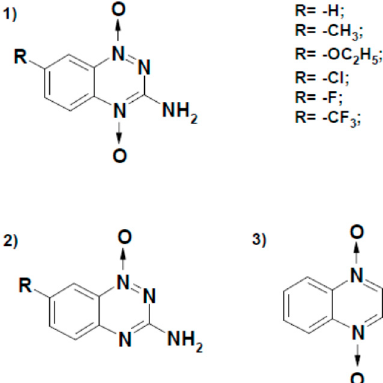
Figure 8. Structural formulae of aromatic N -oxides used in this work. Derivatives of 3-amino-1,2,4-benzotriazine-1,4-dioxide (tirapazamine) (1), 3-amino-1,2,4-benzotriazine 1-oxide (2) and quinoxaline-1,4-dioxide. Formulae were drawn using ISIS / Draw (v. 2002, MDL Information Systems, San Leandro, CA,